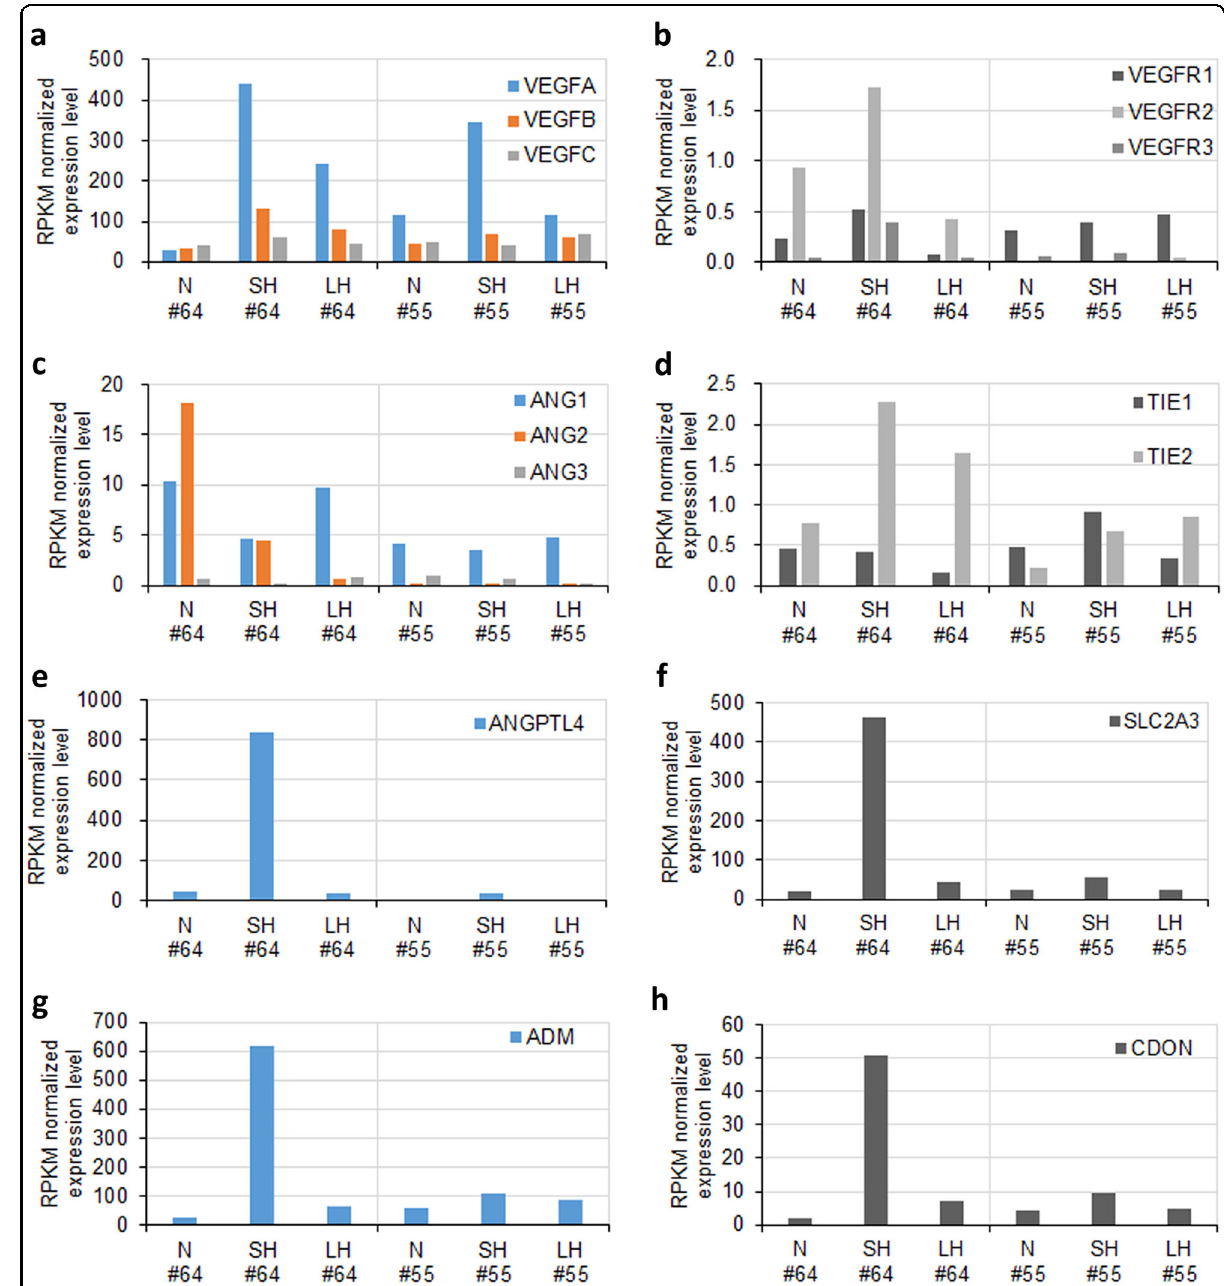
Fig. 6 Genome-wide NGS analysis provides a clue to donor-dependent variations in stem cell therapy for limb ischemia. a – h Expression levels of transcriptomes in six samples N#55, SH#55, LH#55, N#64, SH#64, and LH#64 were analyzed by NGS analysis. The mRNA sequencing analysis was indicated normalized gene expression changes of angiogenic factors (VEGFA, VEGFB, VEGFC, ANG1, ANG2, ANG3 and ANGPTL4; color) and their receptors (VEGFR1, VEGFR2, VEGFR3, TIE1 and TIE2; gray), as well as additional markers (SLC2A3, ADM, and CDON) in both hUCB-MSC lines #64 and #55 as compared to the hypoxic-preconditioned SH- or LH#64 and SH- or LH#55,